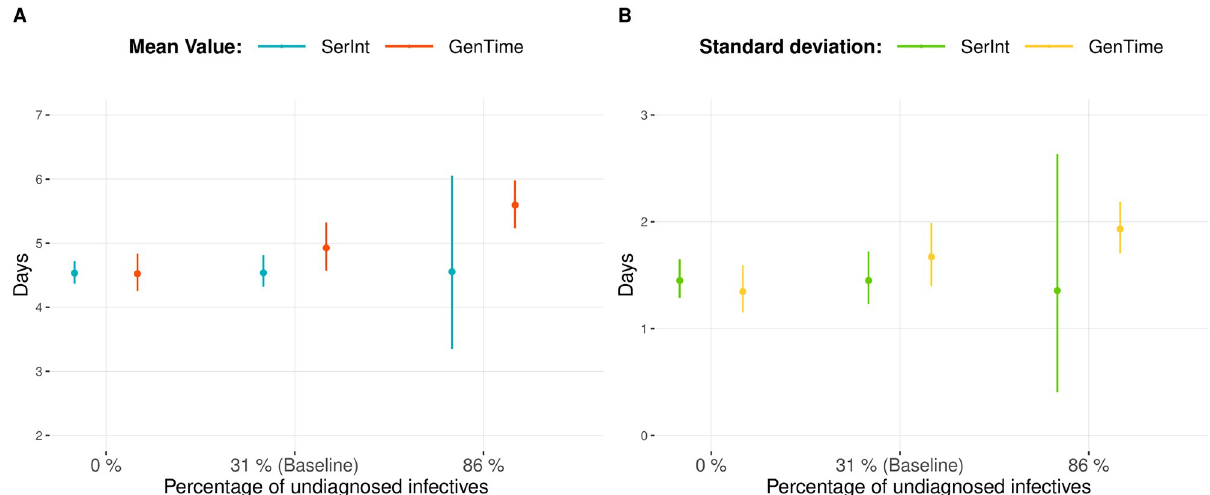
Fig 3. Undiagnosed population—Prevalence. (A) Average and 95% confidence intervals for the mean realized serial and generation intervals and (B) associated realized standard deviations when all the infectives are diagnosed (0%), 31% of infectives are not diagnosed (31%) and 86% of the infectives are not